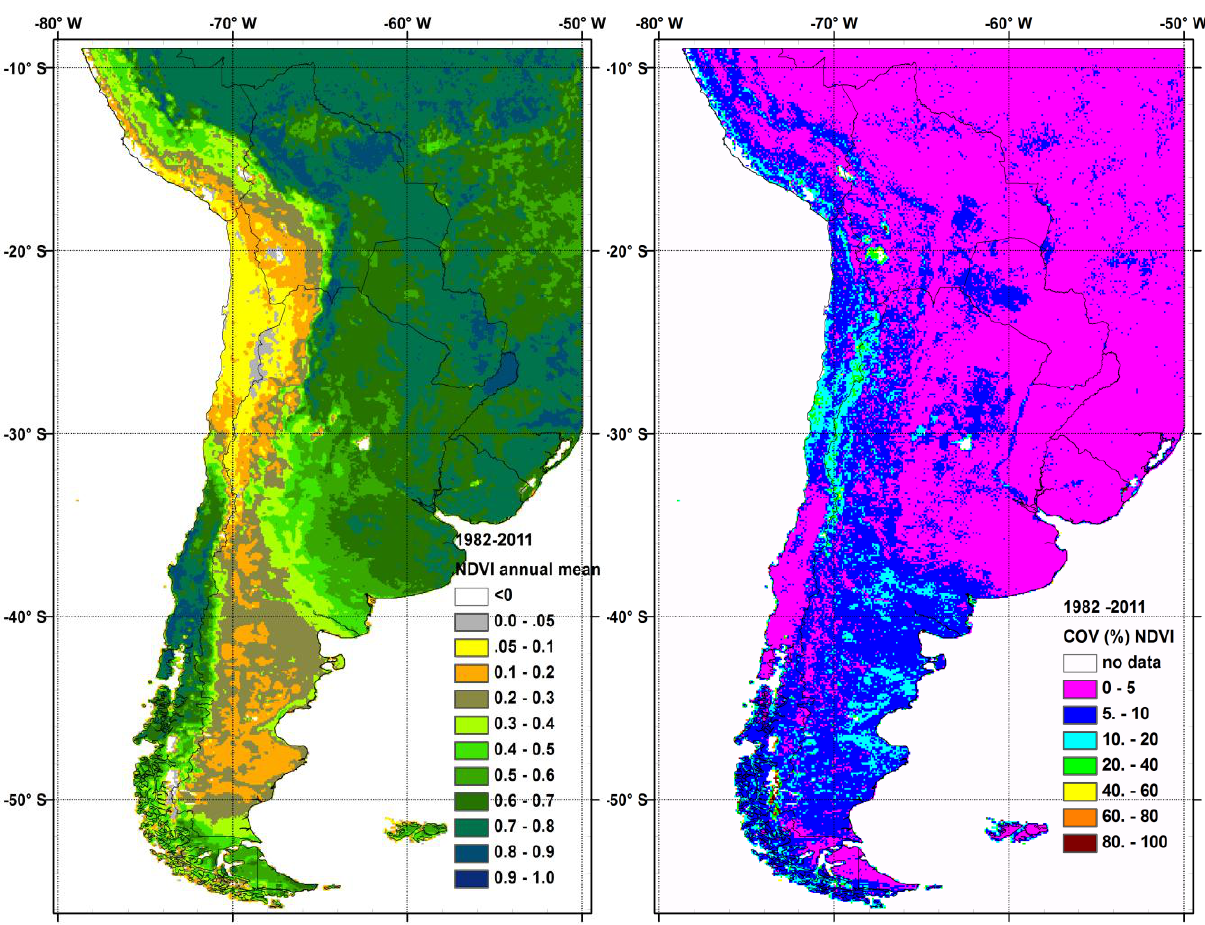
Figure 5. Spatial distributions of the annual mean NDVI and its coefficient of variation (COV) representing the interannual